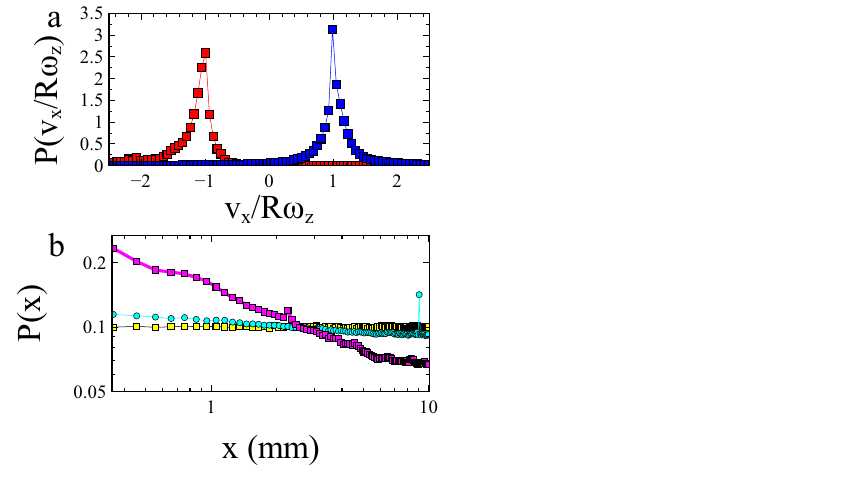
velocity ( ω z ) multiplied by the ball radius ( R ) (i.e. v x / R ω z = 1 ). This is because the relative contact velocity between ball and surface at the point of contact ( v c = v x − R ω z ) is zero. This means the ball and surface do not slide past one another, generating friction, but roll during the bounce. If v x / R ω z deviates from 1 the ball experi- ences a frictional force which either increases v x and decreases R ω z , or vice versa, to push the ball back towards the condition for rolling. In the full simulation, in the middle of the cell these deviations in v x / R ω z from rolling occur due to the random kicks received from the roughened base. One therefore observes a kind of dynamic equilibrium in which the kicks result in deviations from v x / R ω z = 1 (Figs. 1c and 3a) but the nature of a ball bouncing on a frictional surface is to tend back towards the condition for rolling. However, upon reaching the wall there is an additional factor to consider. The collision of the ball with a smooth wall reverses the horizontal velocity ( v ′ x = − v x ) of the ball without changing the sign of its rotational velocity ( ω ′ z = ω z ). If the ball prior to the collision satisfies the rolling condition v x = R ω z , this would then be modified to a value of v ′ x / R ω ′ z ≈ − 1 . Figure 3 illustrates how the reflection due to a wall results in a complete reversal of the distribution of v x / R ω z . The data in red includes only those points which had hit the side wall